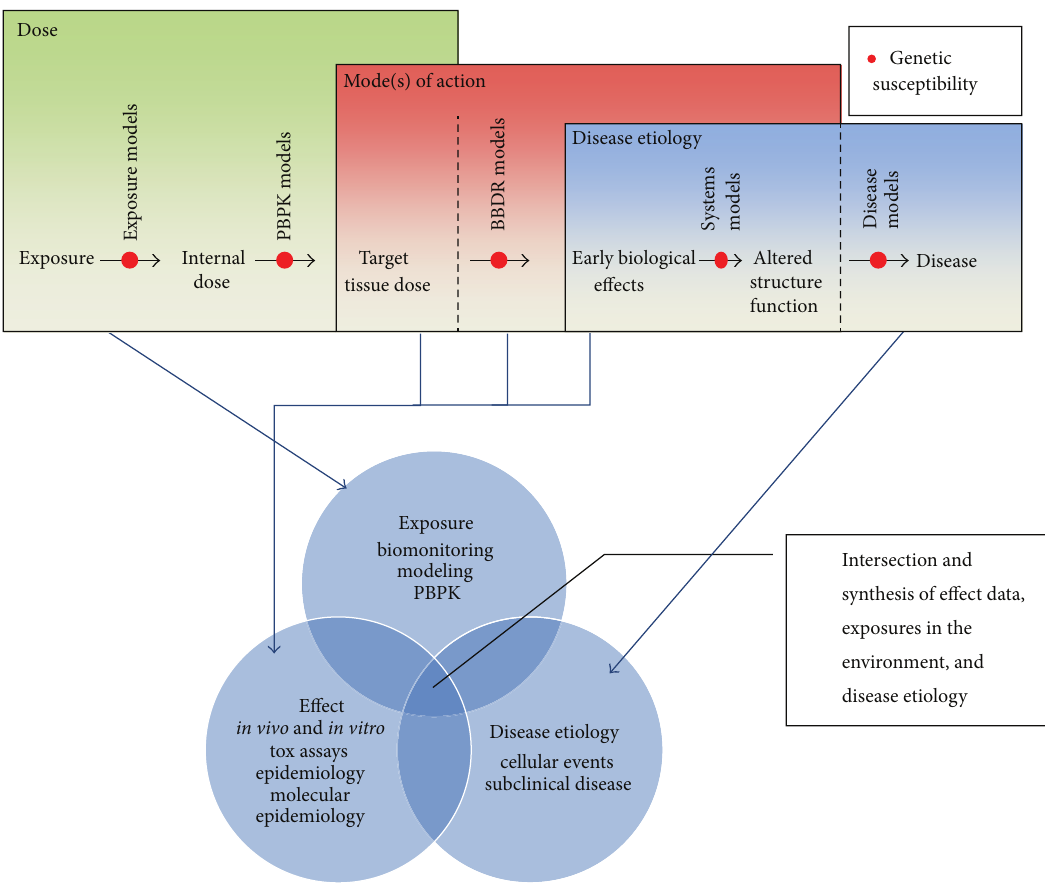
Figure 2: Intersection of data required to evaluate the plausibility of an association between exposure and